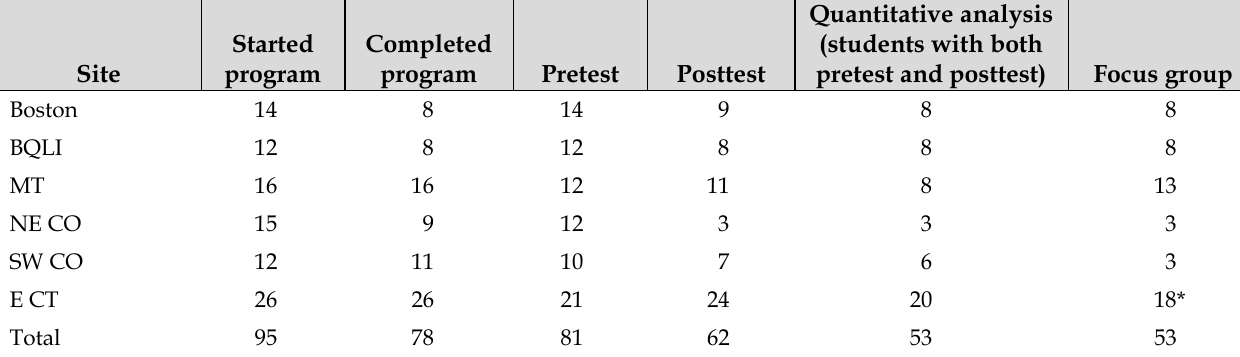
Table 1 Participants in evaluation activities (numbers represent individual students)